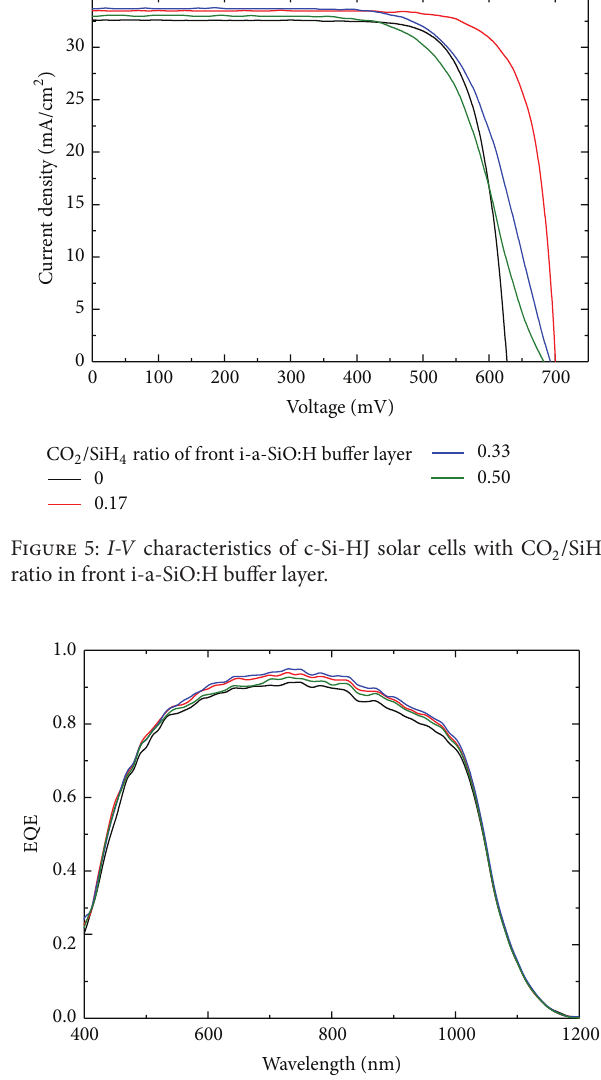
Figure 4: PV parameters and 𝜏 for the front i-a-SiO:H buffer layer.